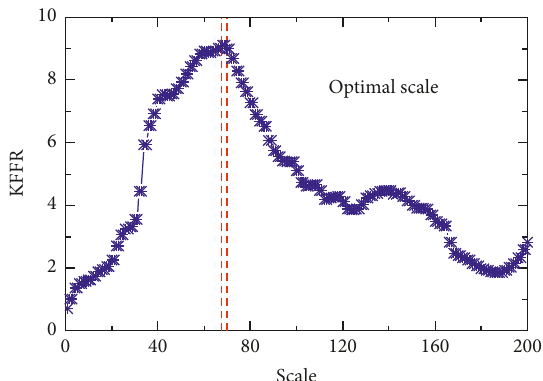
Figure 19: Case 2: KFFR values of filtering results with different scales.